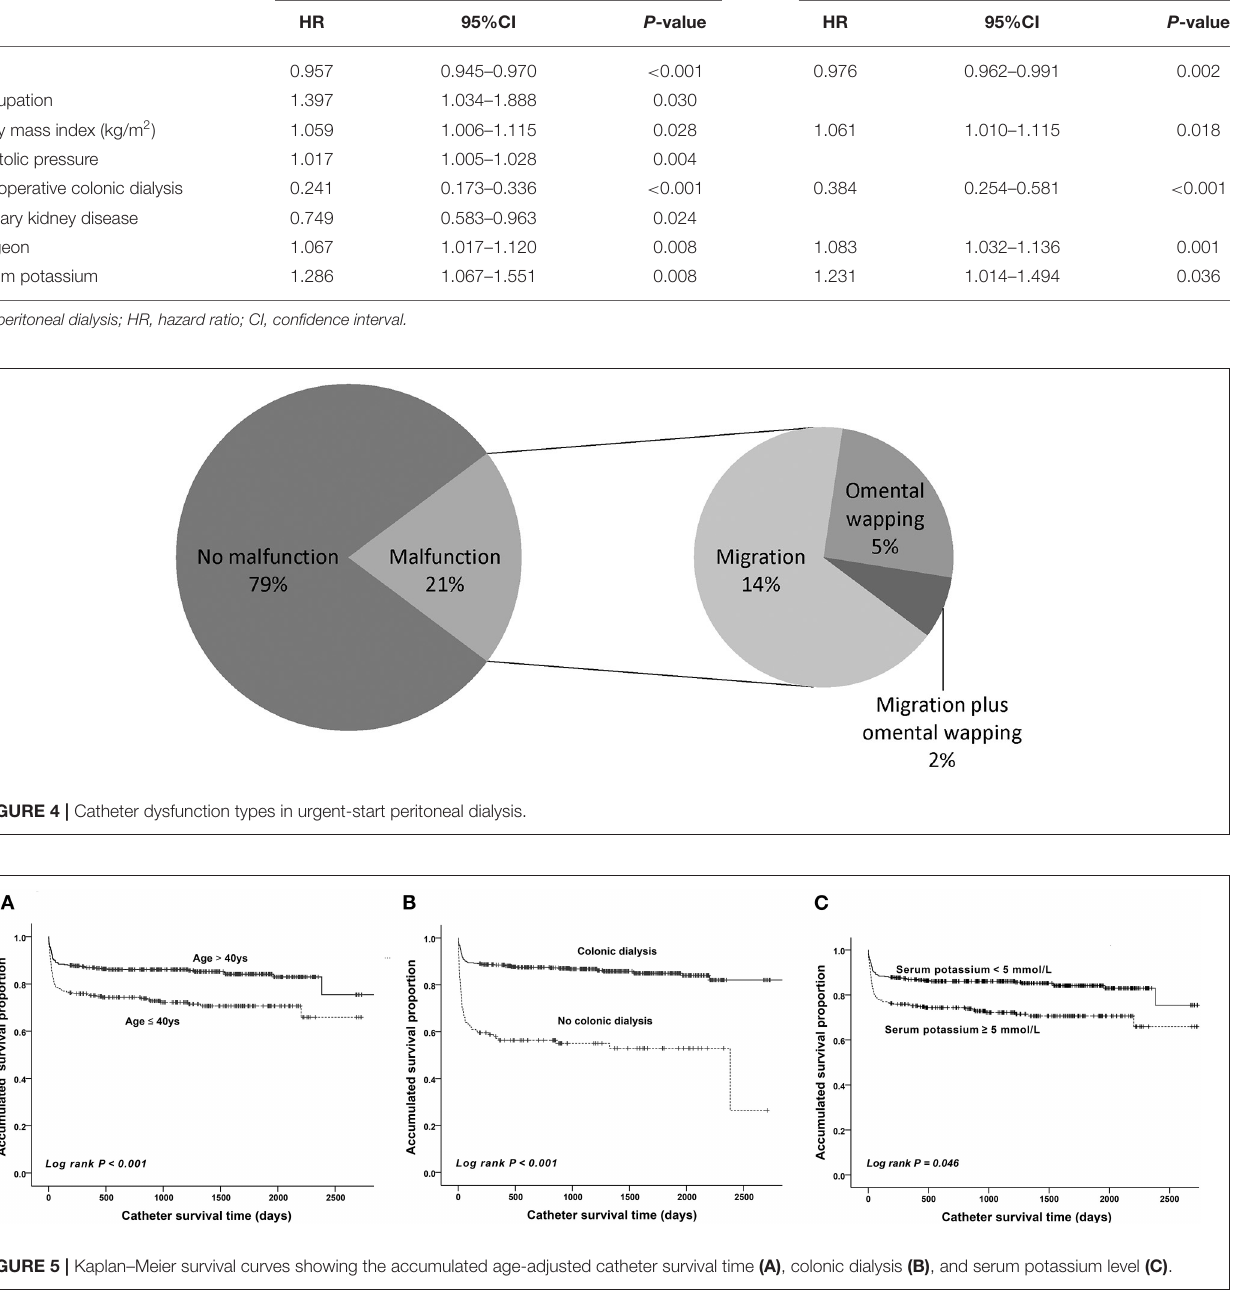
perforations. All patients had good post-incision prognoses, with no occurrence of fat liquefaction or poor